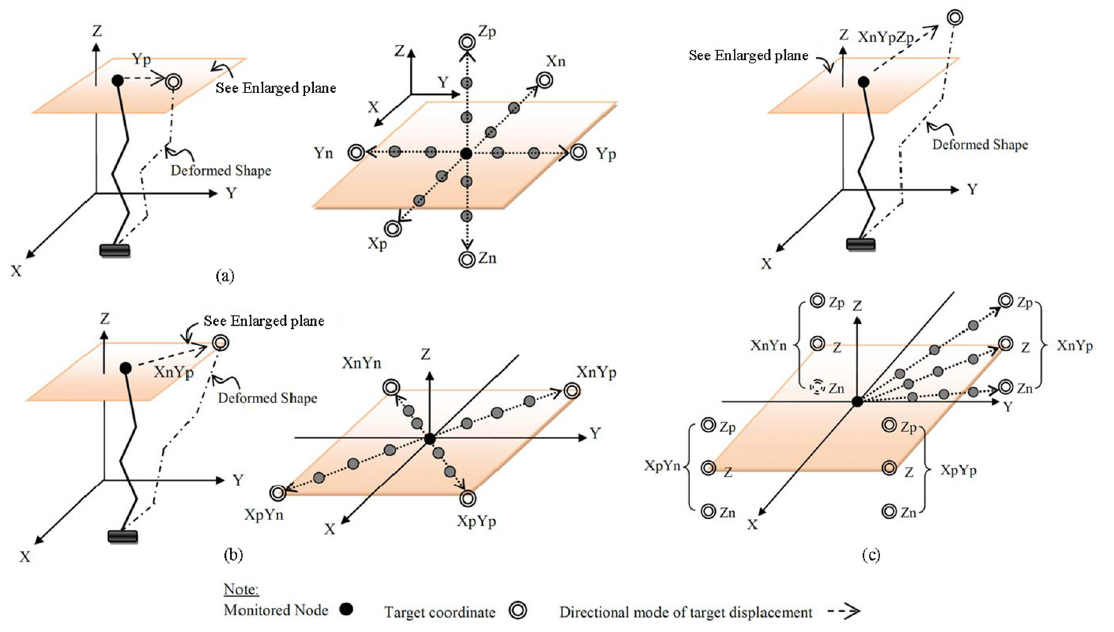
Figure 5. Cases of target displacements: ( a ) uni-directional; ( b ) bi-directional; and ( c ) tri-directional modes.